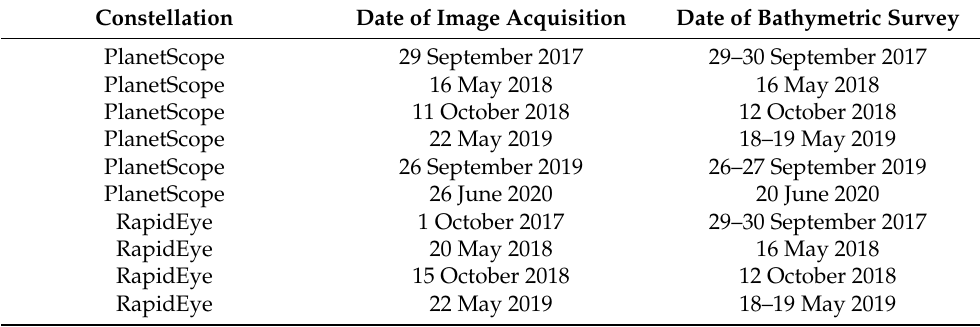
Table 2. The dates of PlanetScope and RapidEye images used for sandbar crest extraction compared with the dates of bathymetric surveys used for accuracy evaluation of satellite-derived crest positions.